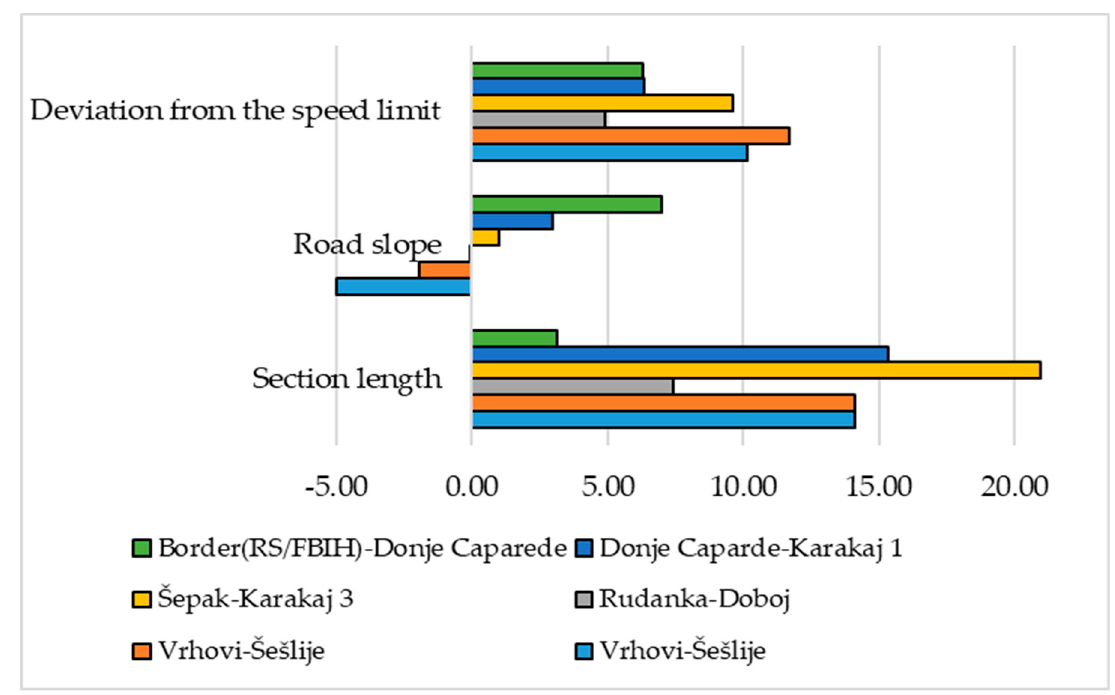
Figure 2. Display of the section length, road slope, and deviation from the speed limit.